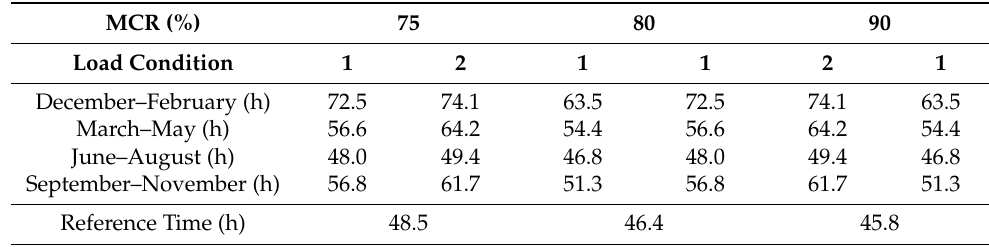
Table 8. Voyage time per season, per Load Condition and per Maximum Continuous Rating (MCR) considered, compared with reference time in calm